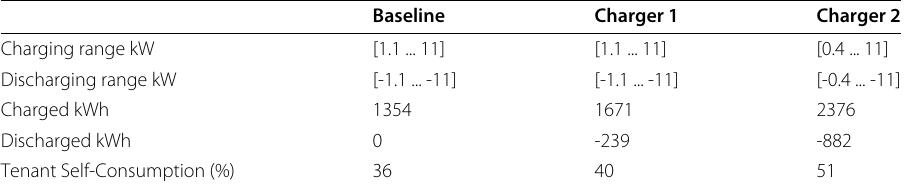
Table 3 Charging power settings and resulting energies for different chargers for